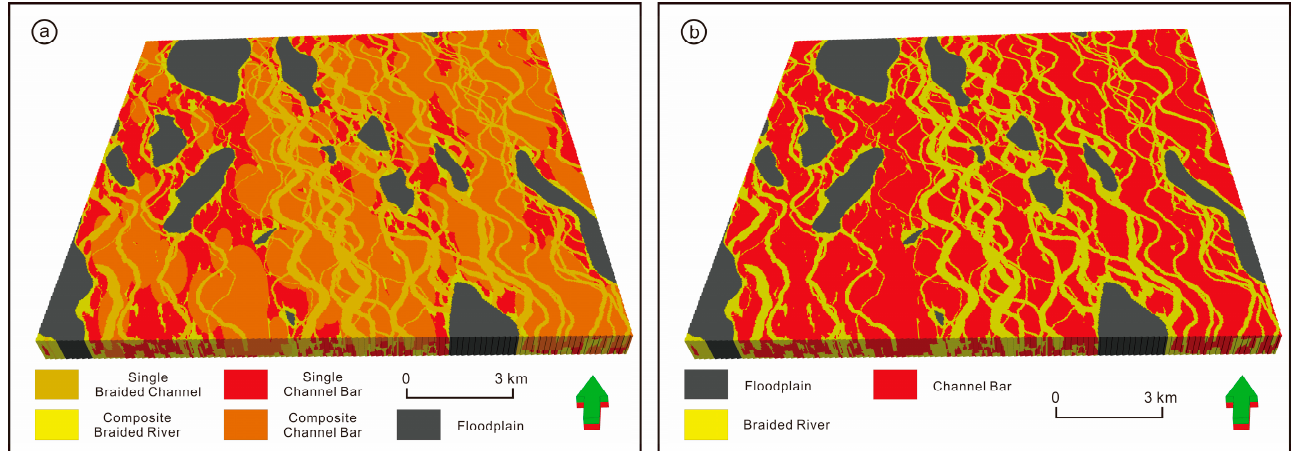
Figure 8. Second hierarchical TI based on 5–4 level architecture units. ( a ) Results of differential mi- crofacies simulation TI 2-1, ( b ) combining microfacies to match conditional data 2 of the TI 2-2.